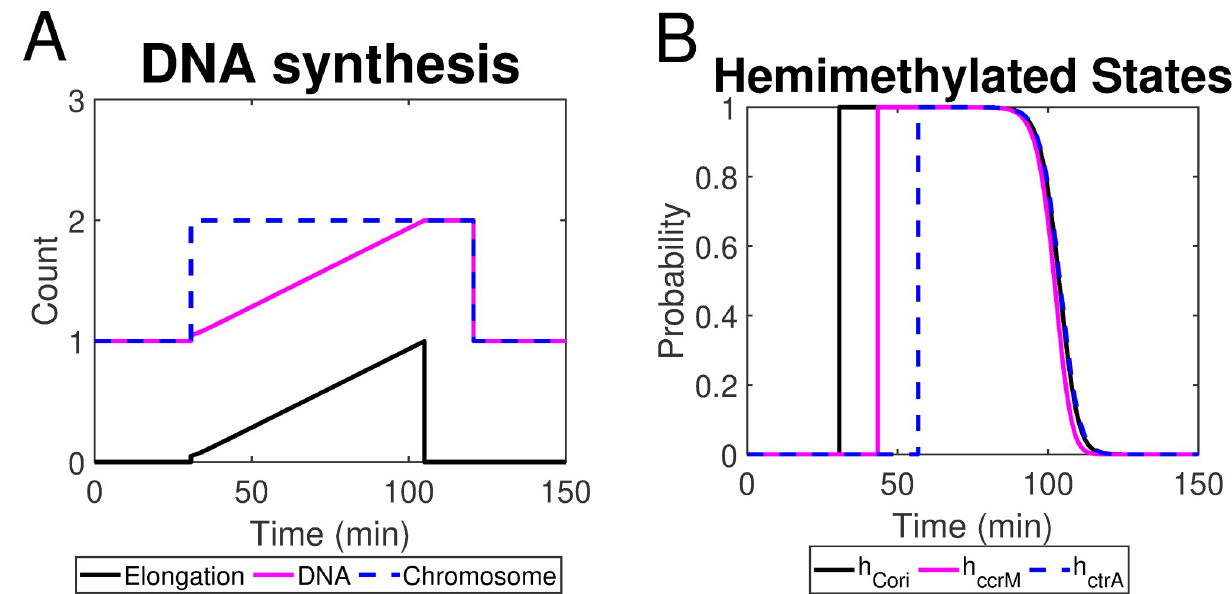
Fig 8. (A) Simulated chromosome/DNA replication and elongation process; (B) The probability of loci ( Cori , ccrM , ctrA ) being hemimethylated in a single cell cycle.